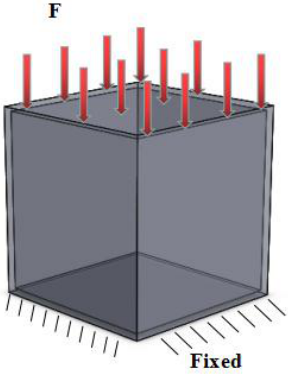
Figure 6. Model of thin-wall parts for finite element analysis.